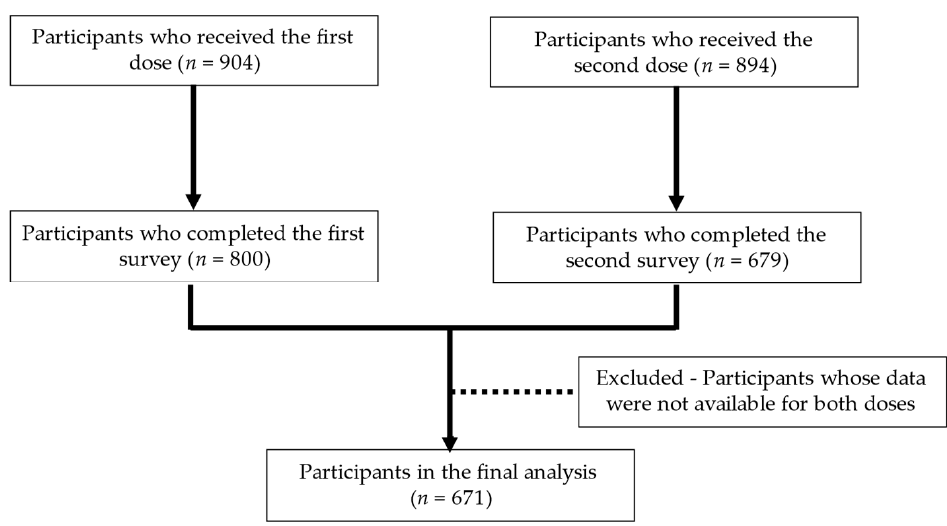
Figure 1. The flowchart of the sample selection process.